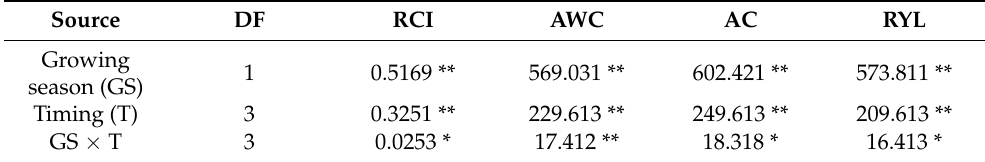
Table 4. Analysis of variance (mean squares) for the calculated competition